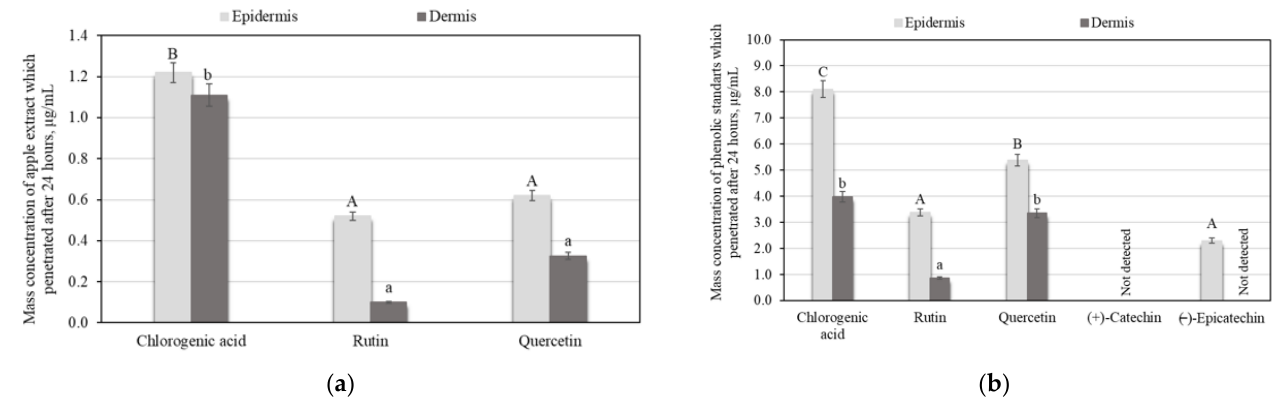
Figure 2. Results of penetration study: ( a ) Penetration of apple extract into skin layers after applica- tion for 24 h; ( b ) Penetration of chlorogenic acid, rutin, quercetin, (+)-catechin, and (−) -epicatechin standard solutions into skin layers after application for 24 h. Uppercase letters indicate a statistically significant difference in the amount of phenolic compounds that penetrated into the epidermis layer; lowercase letters indicate a statistically significant difference in the amount of phenolic compounds that penetrated into the dermis layer ( p < 0.05).